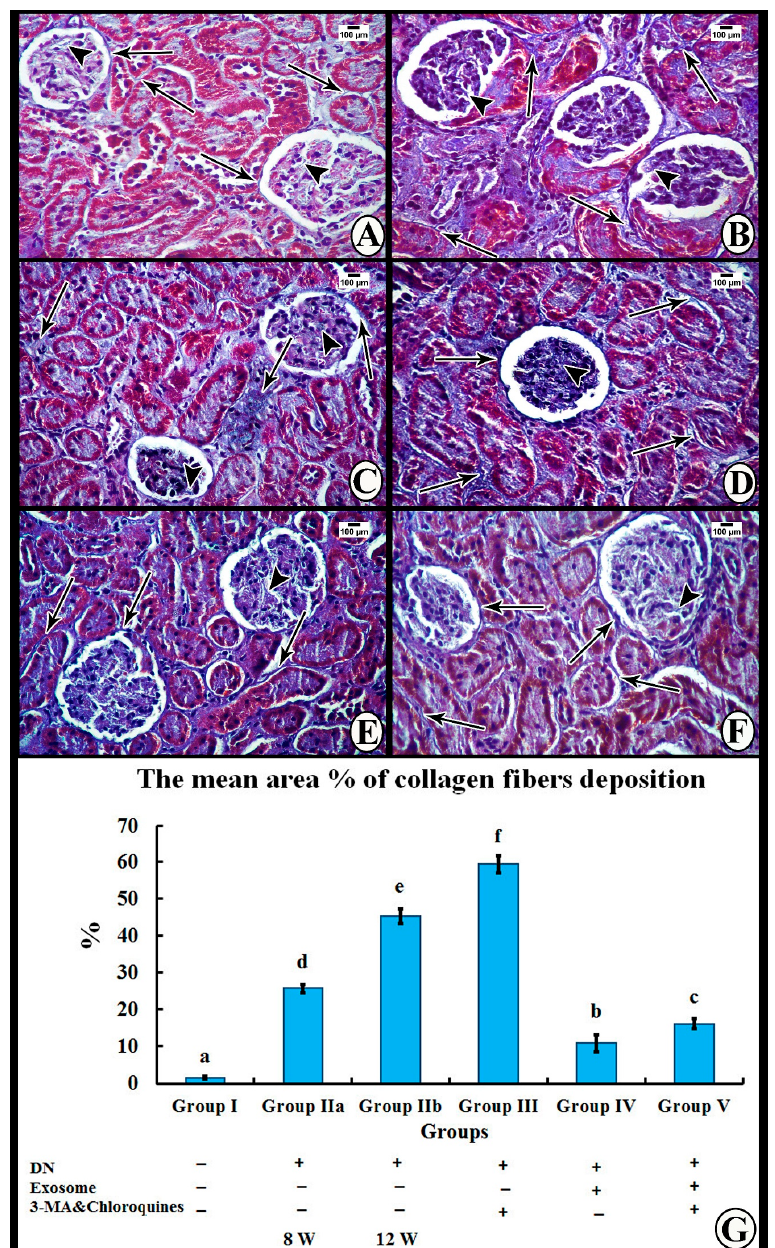
Figure 5. ( A ) Masson’s trichrome stained sections of renal cortex of Group I show minimal collagen fibers among the glomerular capillaries (arrowhead) and surrounding the renal corpuscles and tubules (thin arrows). ( B ) Group IIa demonstrates accumulation of collagen fibers among the glomerular capillaries (arrowheads) and surrounding the renal corpuscles and tubules (thin arrows). ( C ) Group IIb shows marked accumulations of collagen fibers among the glomerular capillaries (arrowheads) and surrounding the renal corpuscles and tubules (thin arrows). ( D ) Group III shows extensive accumulation of collagen fibers among the glomerular capillaries (arrowhead) and surrounding the renal corpuscles and tubules (thin arrows). ( E ) Group IV has few collagen fibers among the glomerular capillaries (arrowhead) and around the renal corpuscles and tubules (thin arrows). ( F ) Group V demonstrates persistent accumulation of collagen fibers among the glomerular capillaries (arrowhead) and surrounding the renal corpuscles and tubules (thin arrows). ( G ) A histogram represents the mean area percentage of collagen fiber deposition in all experimental groups. Different superscripts (a, b, c, d, e, and f) indicate significant differences among the experimental groups at p < 0.05. Data are shown as mean ± SEM, n =